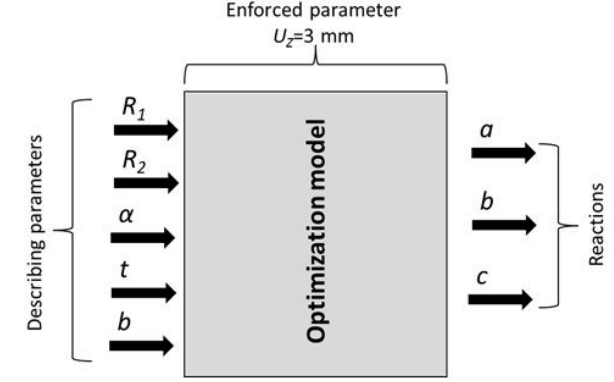
Figure 4: Model of the gasket’s optimization